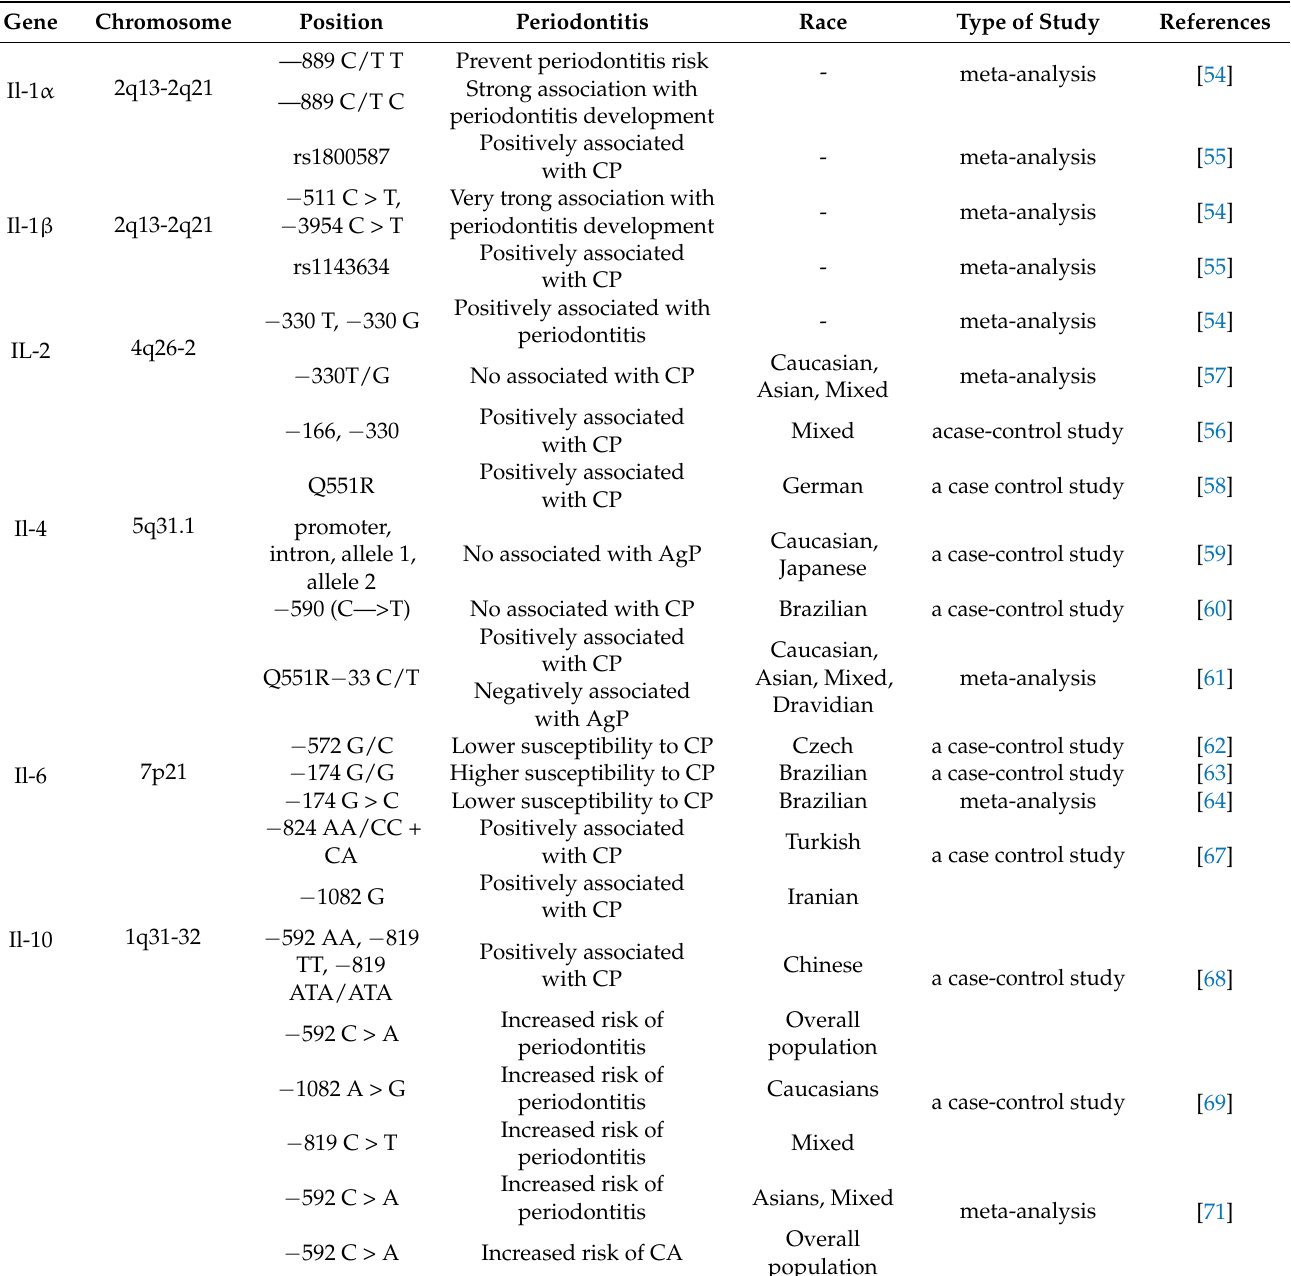
Table 3. Interleukin (IL) gene polymorphisms related to chronic and aggressive